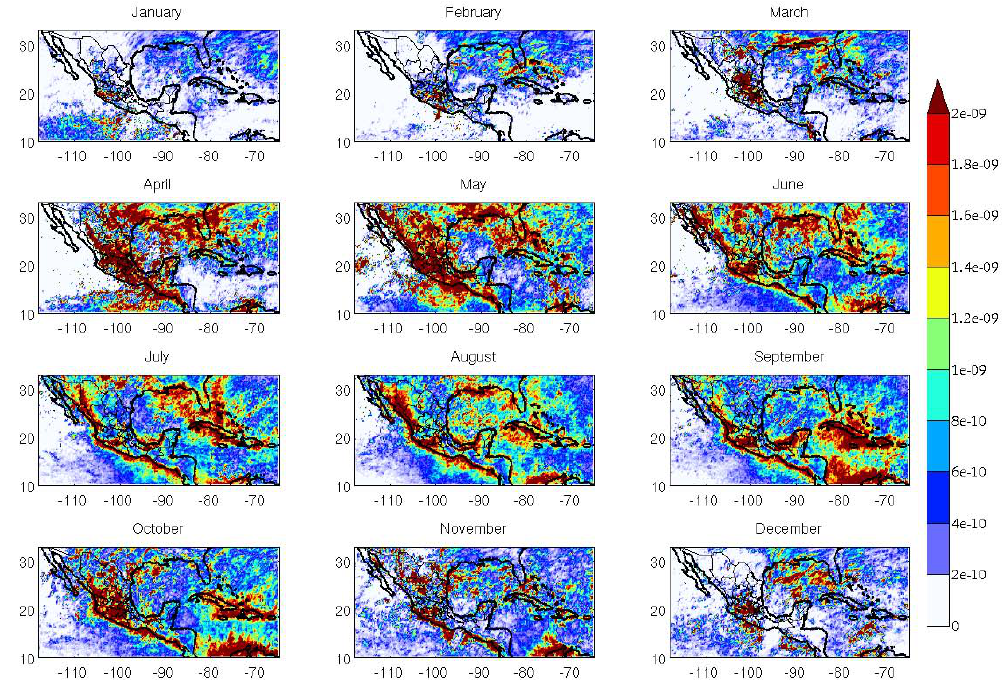
Fig. 2. Monthly distribution of flashes per rainfall [flkg − 1 ] over Mexico and adjacent oceanic regions, averaged over the years 2005–2009.